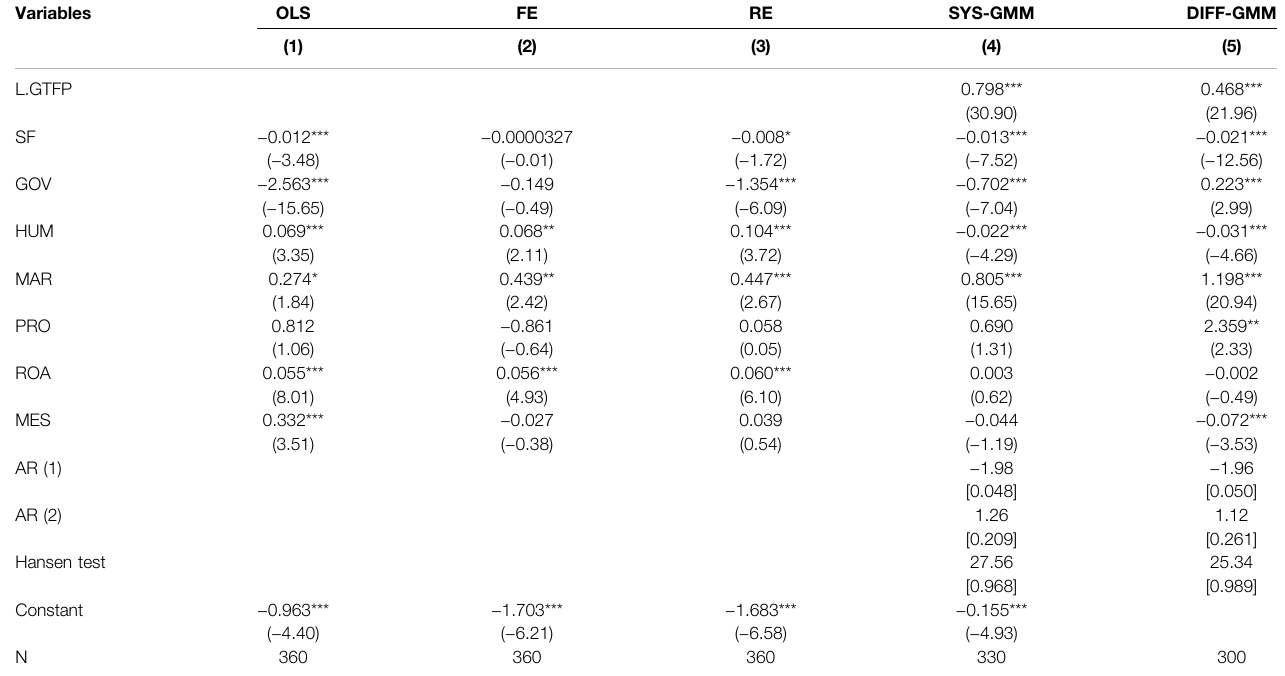
TABLE 8 | Test results of direct effect robustness.